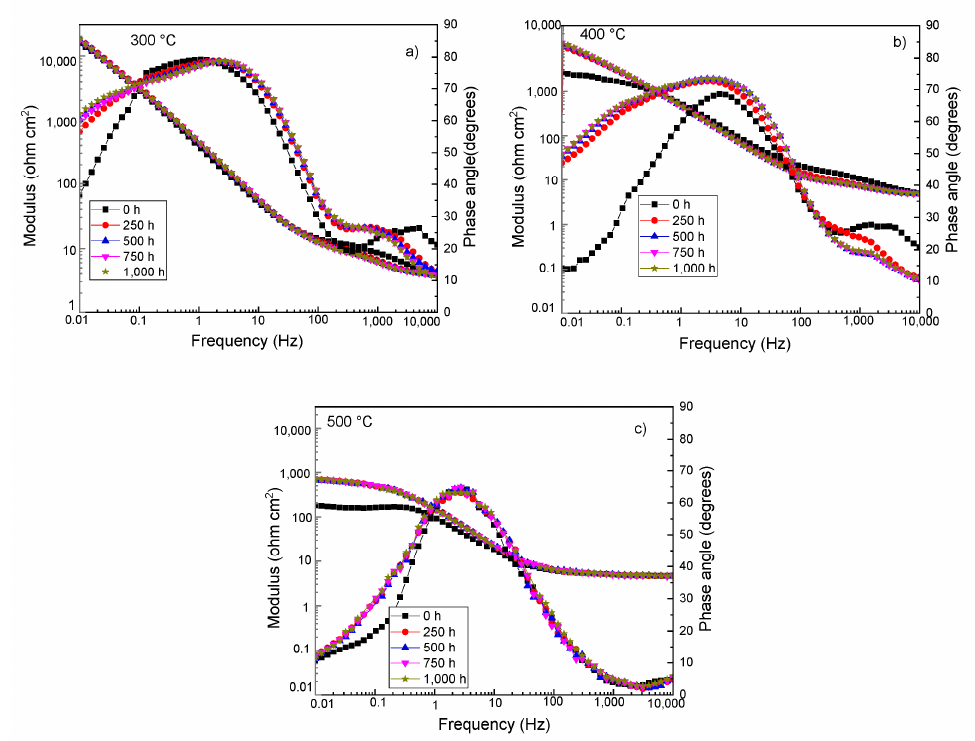
Figure 5. Nyquist diagrams for T91 steel in 60 wt% NaNO 3 -40%KNO 3 at ( a ) 300, ( b ) 400 and ( c ) 500 °C.